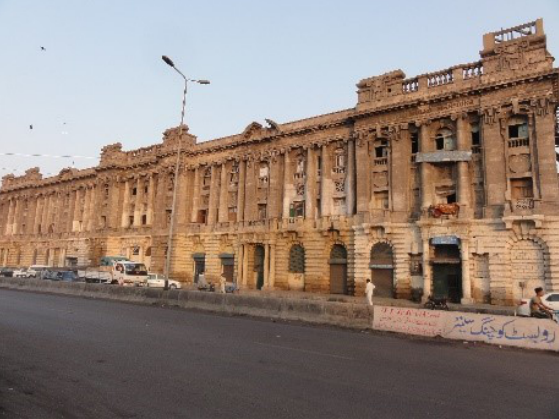
Figure 8. Karachi port Boat wharf entry gate. Figure 9. Mules mansion near Karachi port.